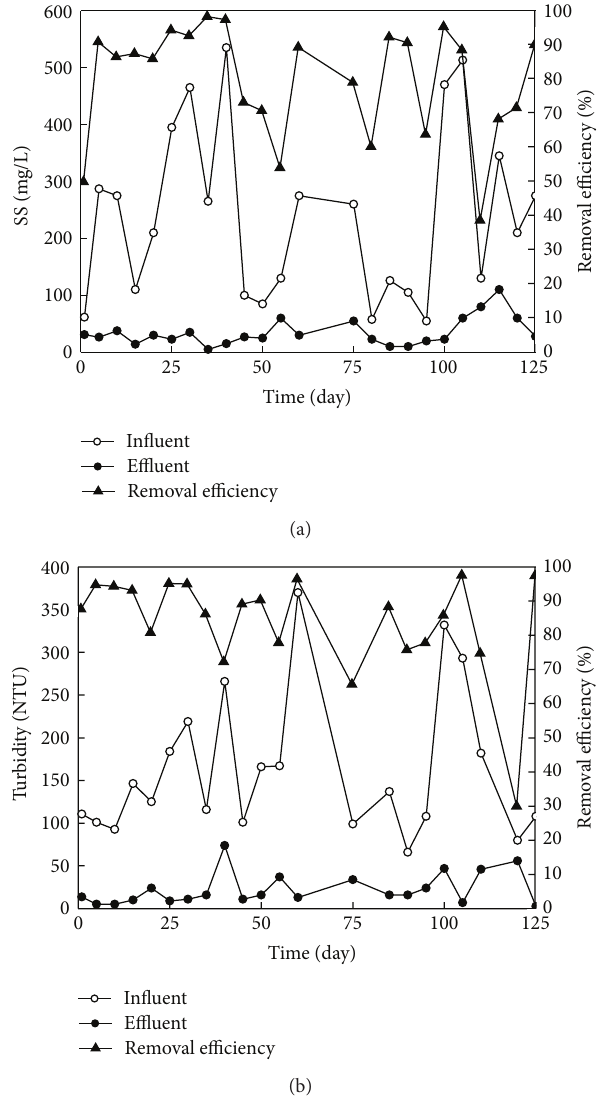
Figure 3: DSTR: (a) SS removal and (b) turbidity